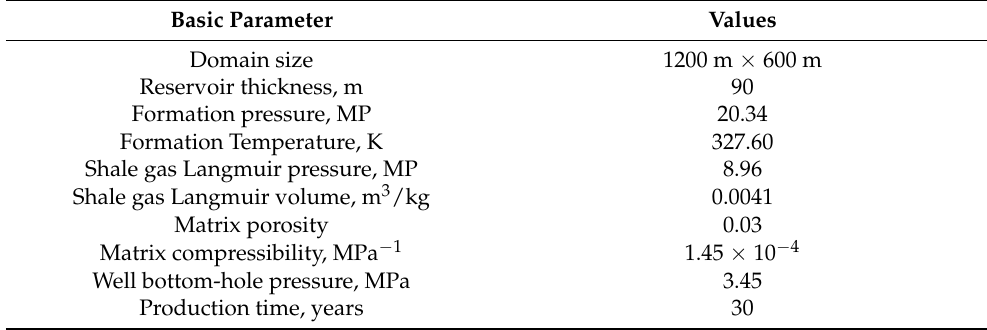
Figure 5. Illustration of multi-well placement in shale gas reservoir. The length and width of shale gas reservoir model are X SG and Y SG , respectively. Table 1. The basic reservoir and fluid properties, e.g., formation size, initial reservoir pressure, tem- perature, Langmuir coefficients for the shale gas reservoir model simulation using MRST-Shale